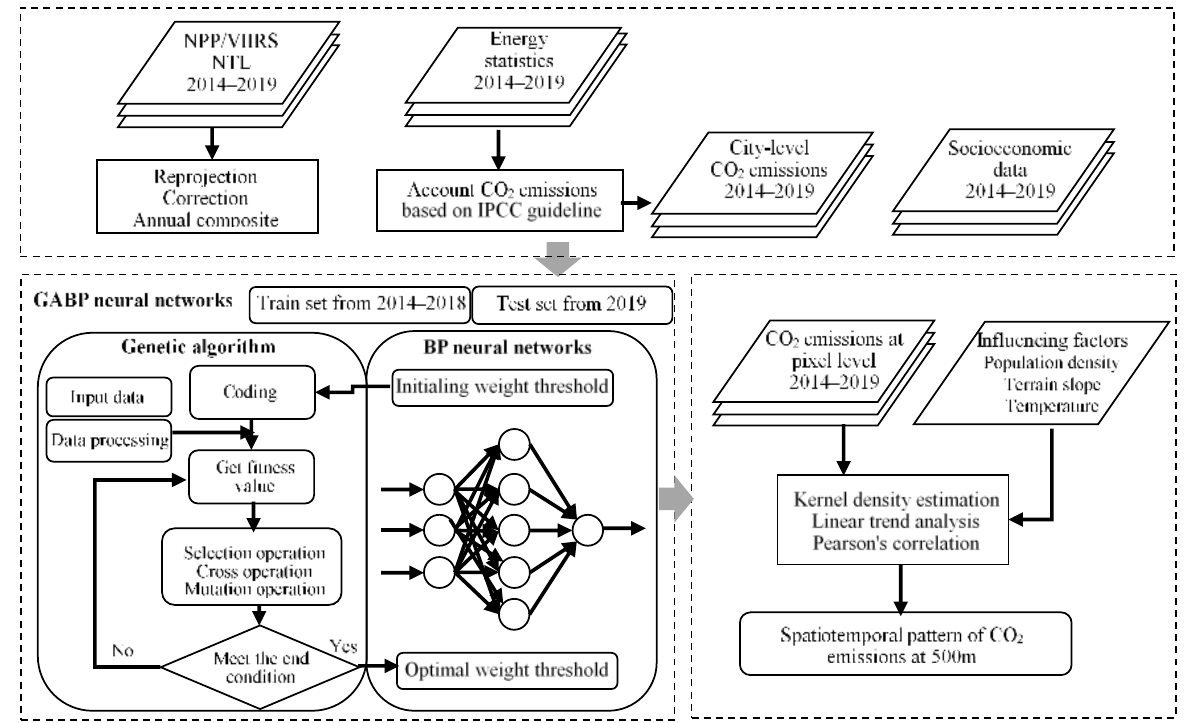
Figure 2. The flowchart of this study.